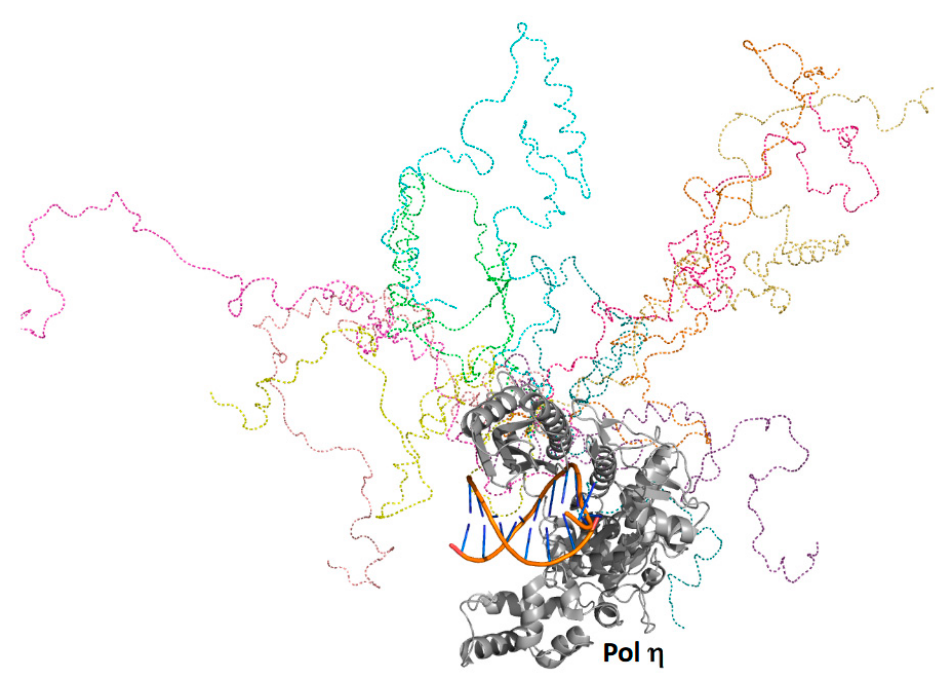
Figure 3. Full ‐ ensemble hybrid methods with full ‐ length pol η . Shown is an overlay of ten randomly selected structures from the full ensemble generated for pol η as described [51]. The catalytic core and the DNA of these ten structures are superimposed, and the intrinsically disordered C ‐ terminal regions of these ten structures are depicted in different colors as dashed lines. Analysis of this experimentally validated ensemble showed that the C ‐ terminal re ‐ gion of pol η is indeed mostly unstructured and samples a wide range of conformational space. Approximately 5% of the time, the C ‐ terminal region is compact and remains near the catalytic core. In another approximate 5% of the time, the C ‐ terminal region is highly extended, stretching far from the catalytic core. The remaining 90% of the time, the C ‐ terminal region occupies a wide range of conformations in between these two extremes. These findings support a model in which the C ‐ terminal region acts as a flexible tether linking the catalytic core of pol η to ubiquitin ‐ modified PCNA, a core component of by ‐ pass complexes. As pol ι , pol κ , and Rev1 also possess similar disordered C ‐ terminal re ‐ gions [10,54], this tethering likely facilitates polymerase sampling, which would be needed to ensure that the most appropriate TLS polymerase is selected to bypass a given type of DNA damage in accordance with the kinetic selection model, which is described elsewhere [11]. 4. Cryo ‐ Electron Microscopy In recent years, cryo ‐ EM has emerged as a major method for obtaining high ‐ resolu ‐ tion structural information of large protein complexes. Compared to X ‐ ray crystallog ‐ raphy, cryo ‐ EM requires small amounts of purified protein. These complexes are frozen in a thin layer of ice, and cryo ‐ EM images are taken. Images of particles are averaged and 2D class averages are obtained. Ultimately, a 3D reconstitution of the electron density of the complex is determined. Two cryo ‐ EM studies of TLS polymerases have led to signifi ‐ cant advances in our understanding of the mechanisms of these proteins. These two stud ‐ ies will be discussed below. 4.1. DNA Polymerase Zeta